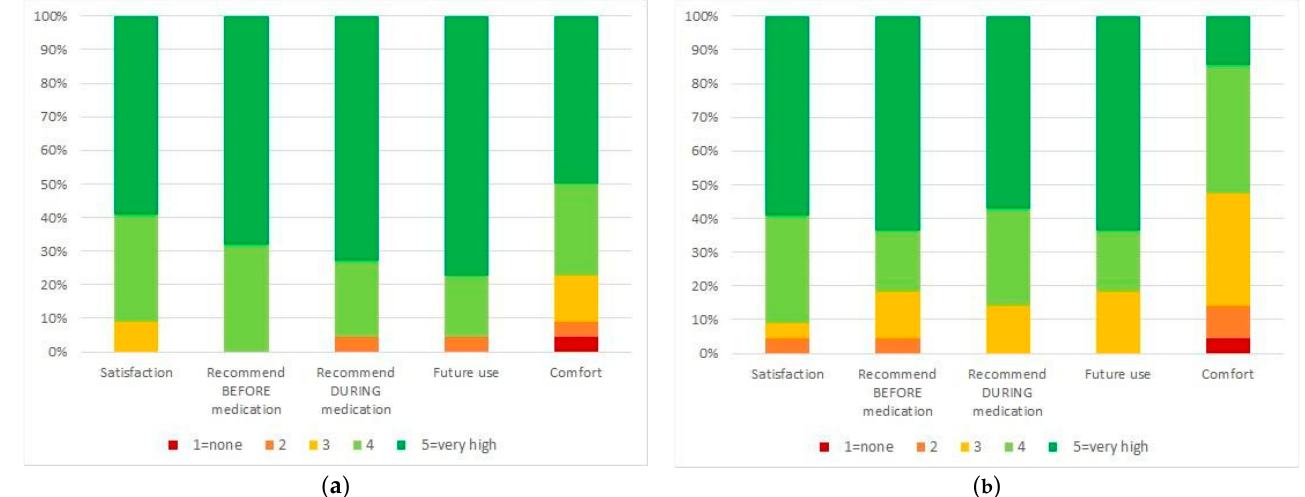
Figure 4. Satisfaction questionnaire results of families and children ( a ) families; ( b ) children.